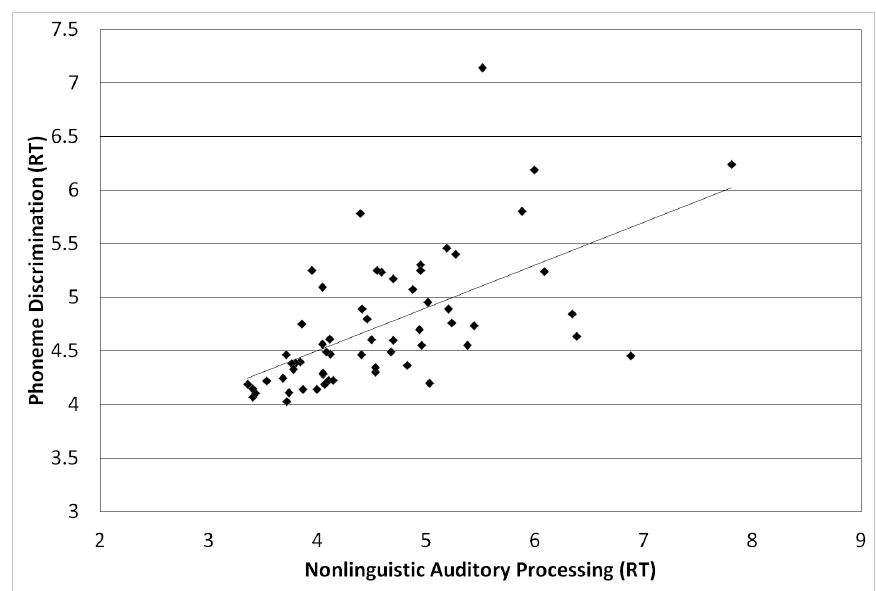
Figure 1. Correlations between RTs on nonlinguistic auditory processing and phoneme discrimination, r (59)= .60, p , .001.